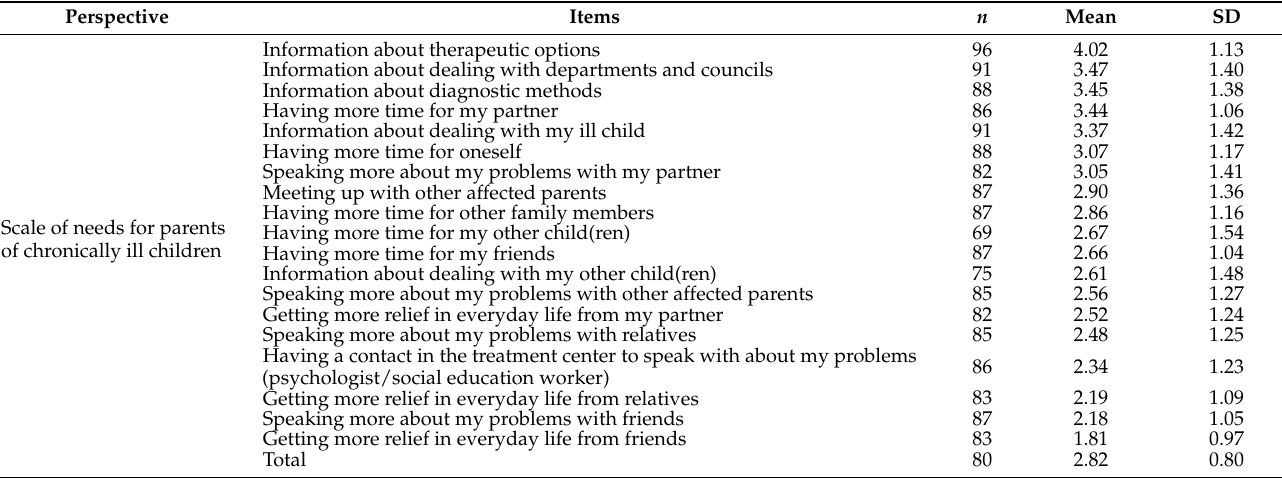
Table 9. Parental Needs (Scale of needs for parents of chronically ill